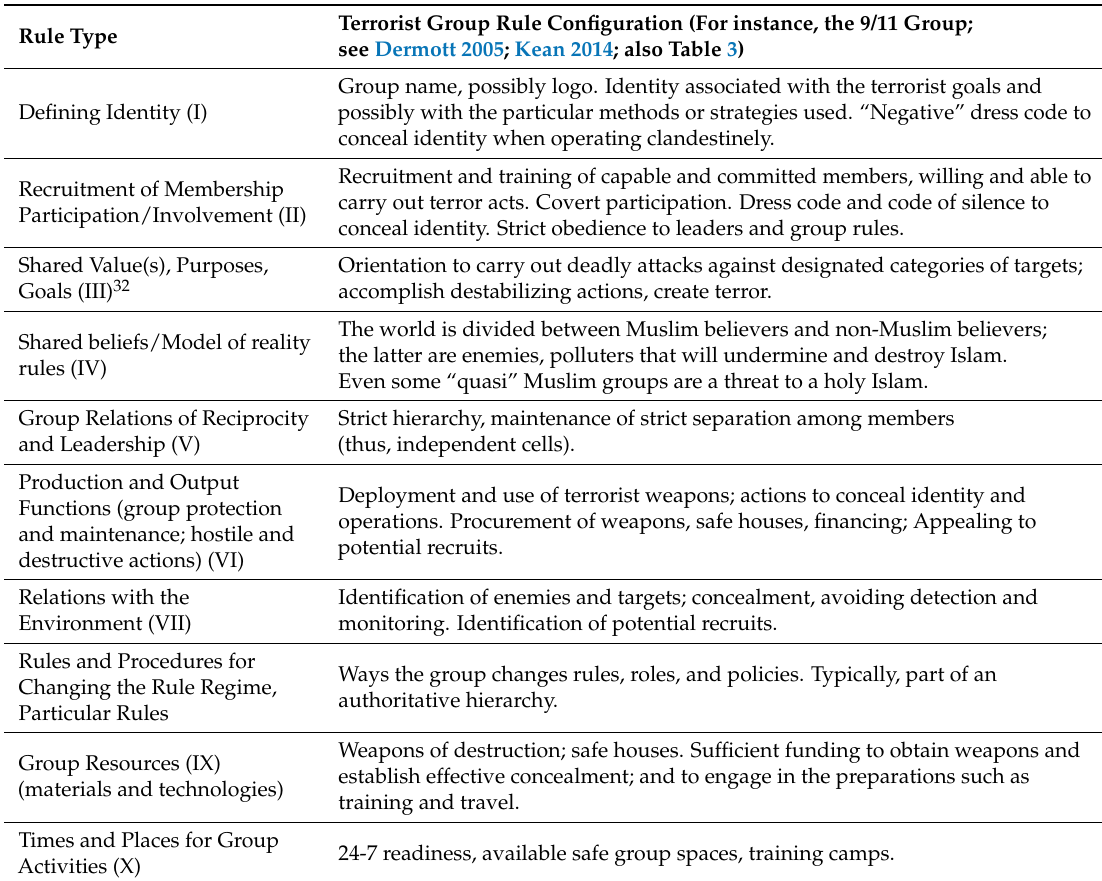
Table 2. Illustration of a Particular Group Rule